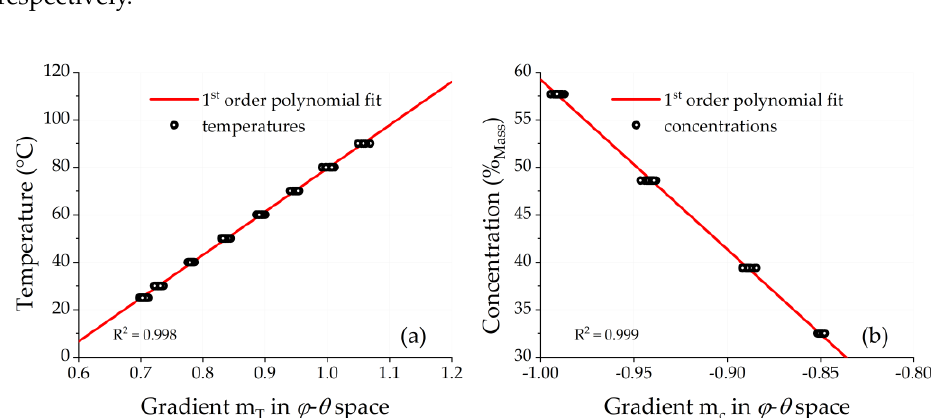
Figure 8. ( a ) Predefined temperatures of each measurement over gradients m T calculated between measurements, intersection point P T in 𝜑 - 𝜃 space (black dots) and corresponding first-order poly- nomial fit (red solid line). ( b ) Predefined concentration values of each measurement over gradients mc are calculated between measurements, intersection point P C in 𝜑 - 𝜃 space (black crosses) and corresponding first-order polynomial fit (red solid line).